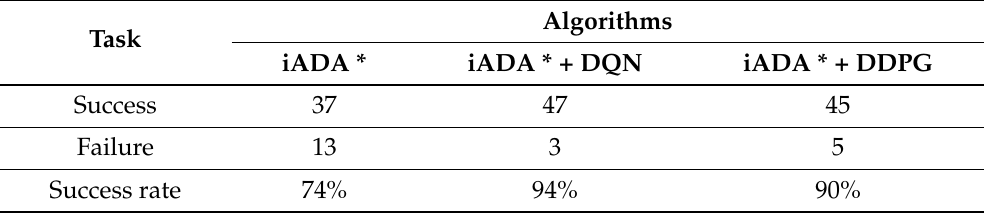
Table 2. Comparison of success rates for different approaches for 50 test cases in a dynamic